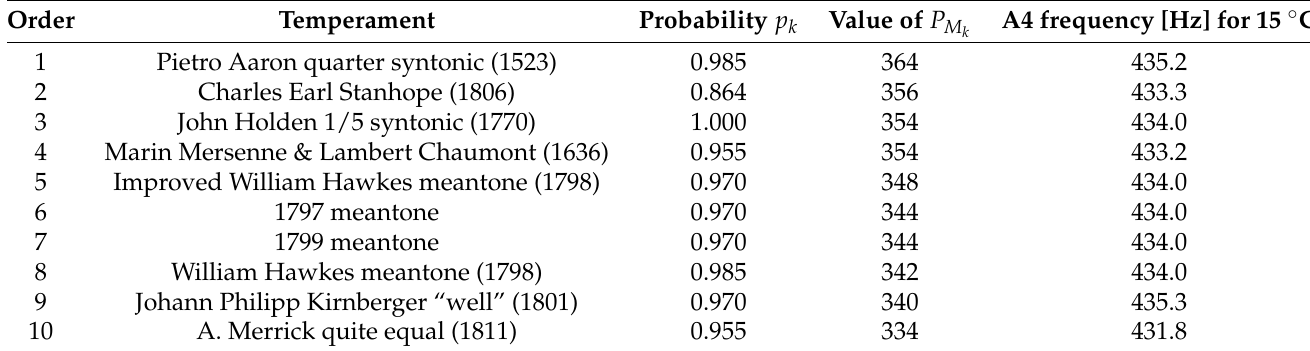
Table 7. Ten best temperament search